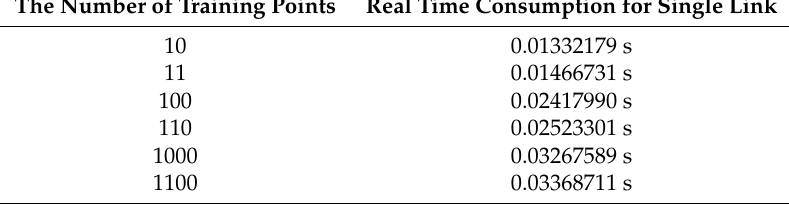
Table 2. The real time consumption of once Hidden Markov Model (HMM) training with different points for a single